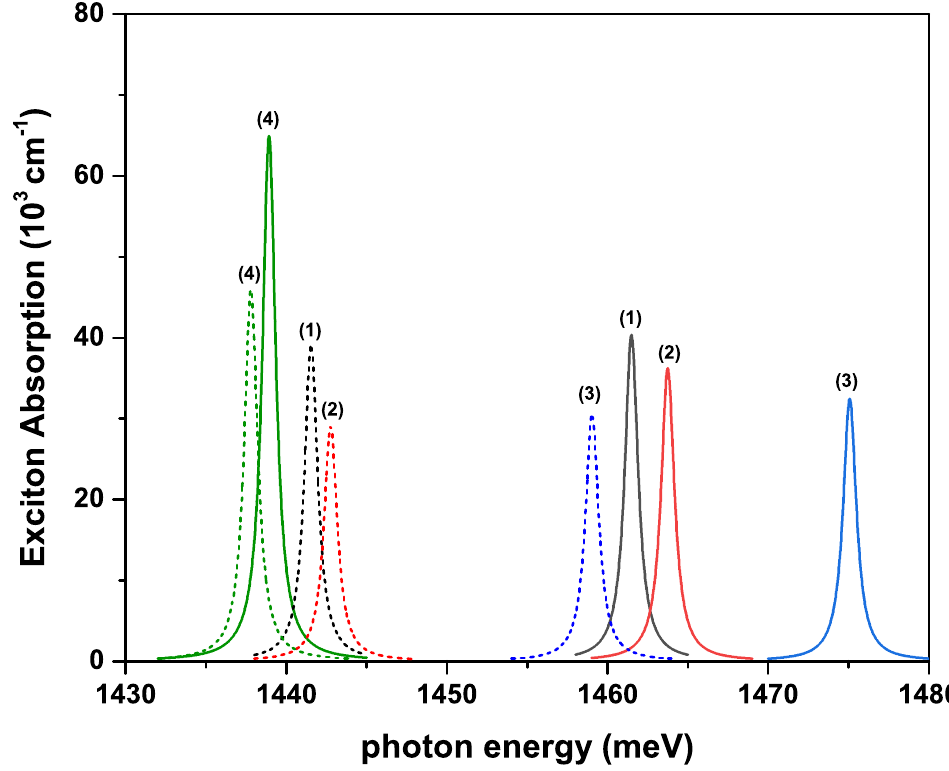
Figure 4. Exciton absorption coefficients for interband transitions as a function of the incident photon energy for confinement potential V 1 ( z e ( h ) ) with ν 1 = 1. Several combinations of the fields ( F , B , α 0 ) (with F in kV/cm, B in Tesla, and α 0 in nm) were considered and are indicated by labels 1, 2, 3, and 4: (0,0,0) (1), (25,0,0) (2), (0,10,0) (3), and (0,0,10) (4). Solid lines are for L ef f = 10nm, whereas dashed lines are for L ef f =